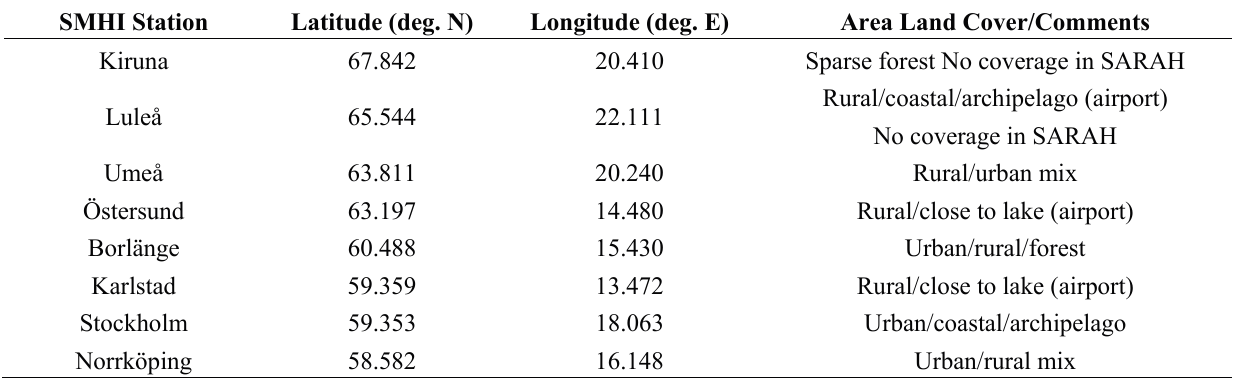
Table 1. Locations of the SMHI and FMI SSR measurement stations used in this study. SMHI